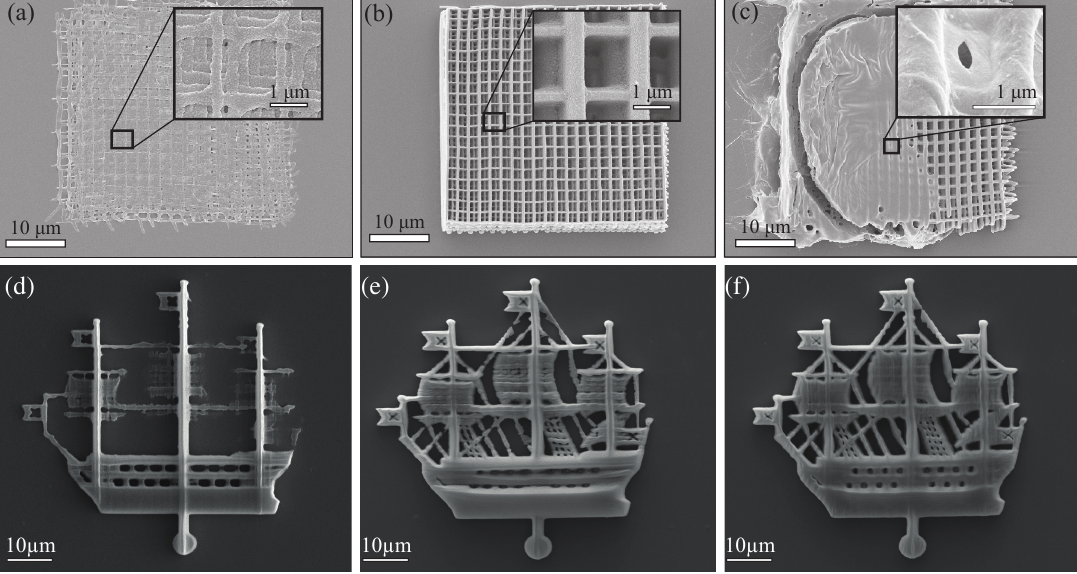
Figure 2. Scanning electron microscopy images of woodpile photonic crystals fabricated at: low ( a ); normal ( b ) and high ( c ) exposure; ( d – f ) scanning electron microscopy images of the wind vane from the top of the Admiralty in Saint Petersburg, Russia, fabricated at different